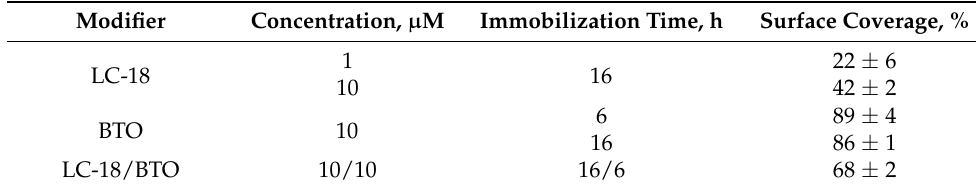
Table 3. Surface coverage of the gold electrode with LC-18 and BTO under varying concentrations or immobilization